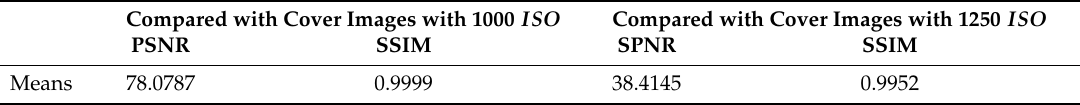
Table 2. The visual quality of the sharing images in